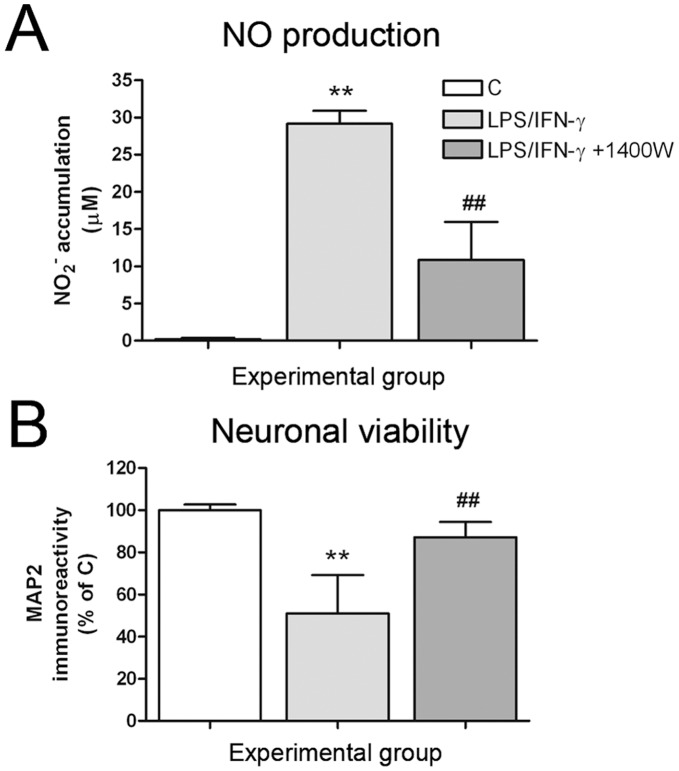
The iNOS inhibitor 1400 W prevented the neurotoxicity induced by reactive microglia in neuron-primary microglia co-cultures.Neuron-primary microglia co-cultures were treated with 100 ng/mL LPS +30 ng/mL IFN-γ for 48 h in the presence or absence of 1400 W (10 µM) co-administered with LPS/IFN-γ. (A) NO production 48 h after LPS/IFN-γ treatment. (B) Evaluation of neuronal viability by MAP2-ABTS-ELISA assay. Results are presented as % of MAP2 immunostaining in control co-cultures. Bars are means + SEM of three independent experiments. **p<0.01 vs control; ##p<0.01 vs LPS/IFN-γ; one-way ANOVA (repeated measures) and Newman-Keuls post-test.